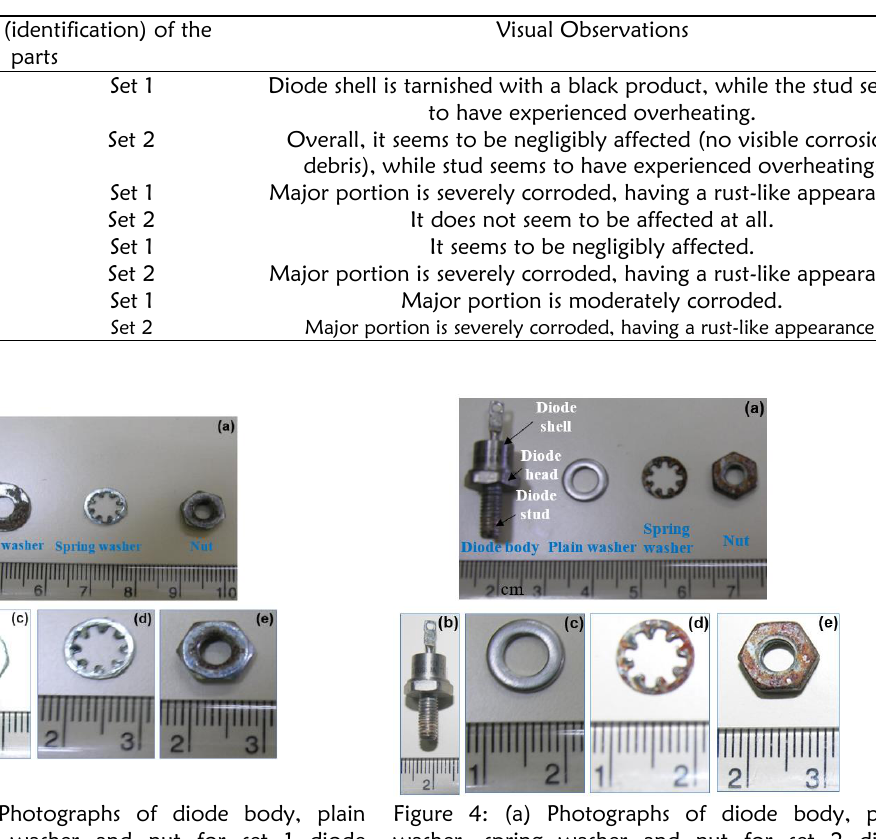
Table 1: Visual observations as captured by photography